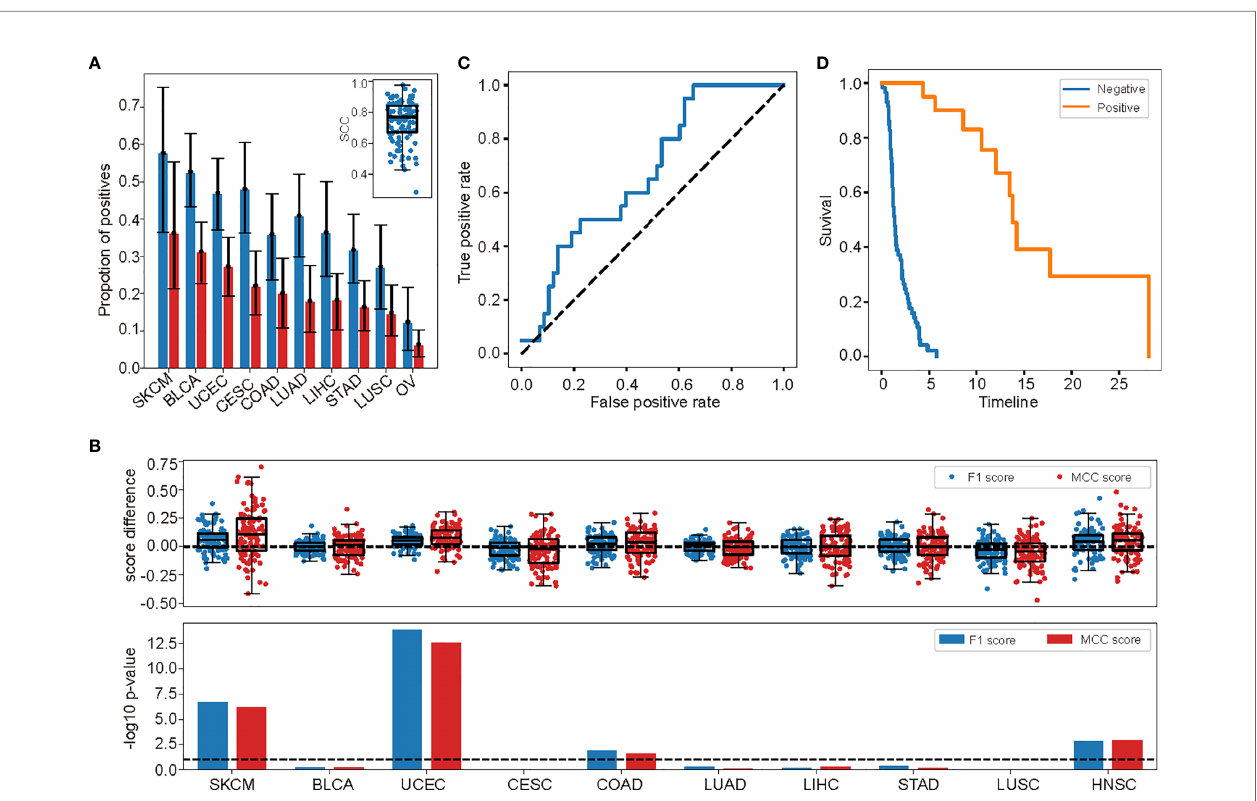
FIGURE 5 | The methylation level – based prediction model was highly performed at speci fi c tumor type level. (A) The proportions of cases marked as positive in the 10 investigated tumor types. Bars and error bars indicated the mean and 95% con fi dent intervals among the 100 randomly split test sets. The distribution of the correlation coef fi cients of these proportions in each test set were shown in the embedded panel. (B) The differences of the performance measurements ( F 1 score and MCC score) in each tumor type among the 100 randomly split test sets (upper) measuring between model based on the selected probes and randomly selected probes. The signi fi cance of these differences (-log10 p-value) were shown in the lower panel. The dashed line marked p=0.1. (C) The ROC curve of the independent validation cohort. (D) The survival curves of cases predicted as responsive and non-responsive in the validation